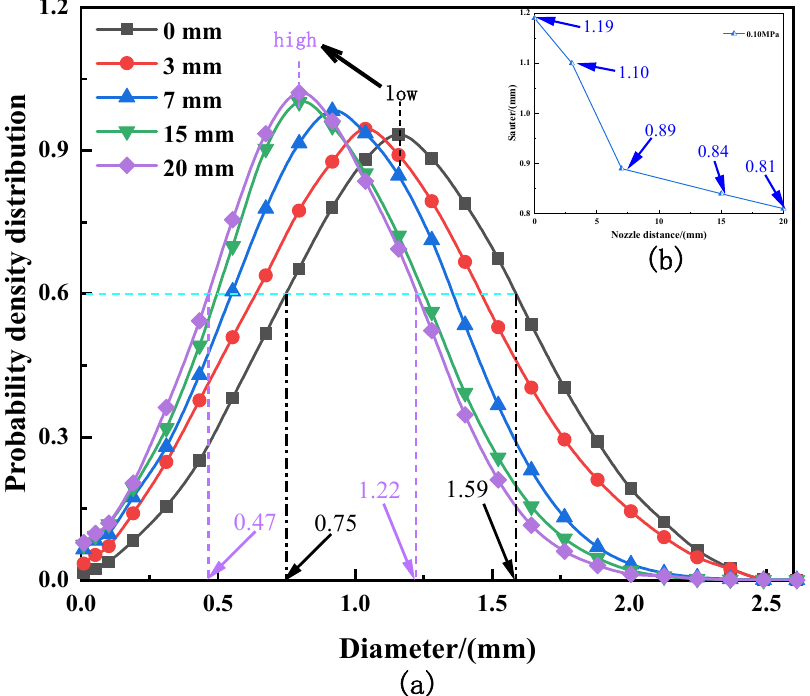
Figure 8. Influence of tube-nozzle distances on bubble size distribution. ( a ) Bubble probability density distribution at 0.10 MPa; ( b ) Sauter diameter variation of bubbles.